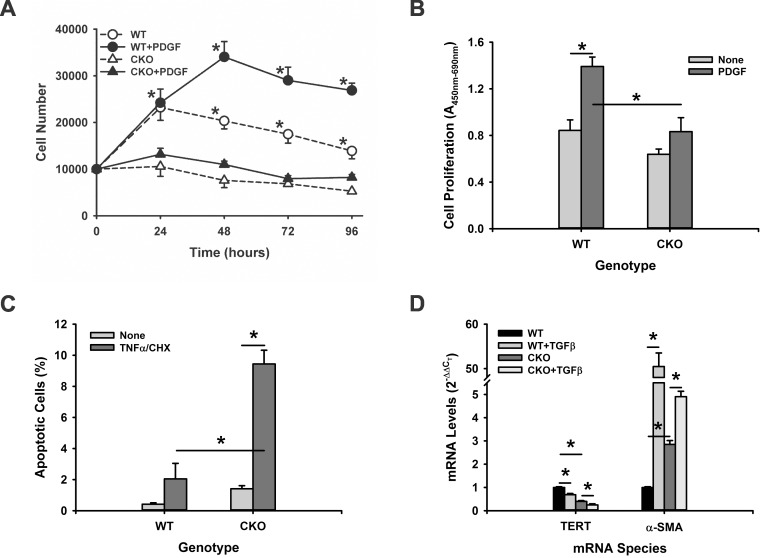
Effects of TERT CKO on MLF proliferation, apoptosis and differentiation.(A) The MLF were isolated from TERT CKO and control mice, and analyzed for proliferation by counting the cell numbers at the indicated time points. n = 5. (B) MLF proliferation by WST-1 assay at 48 hours after PDGF treatment. n = 6. (C) Apoptosis was also detected in MLF by annexin V-FITC/PI staining and flow cytometry without and with TNF-α/CHX treatment. The FITC+/PI- cells were referred to as the apoptotic cells. n = 3. (D) MLF isolated from TERT CKO or control mice were cultured and analyzed for TERT and a-SMA mRNA expression after treatment with buffer only or with TGF-β1 for 48 hours. The mRNA expression levels were expressed as the fold changes over the WT MLF for each gene. n = 3. *, P < 0.05.